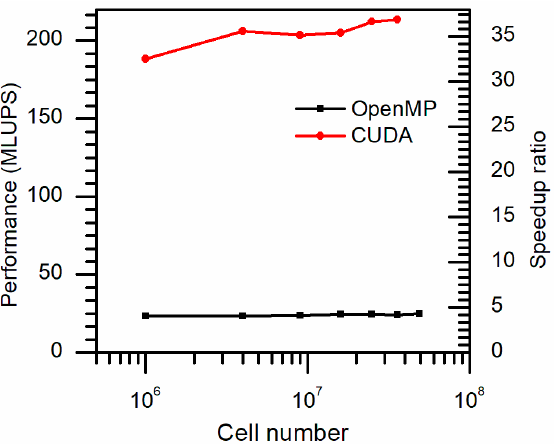
Figure 13. Performance and speedup ratio of the CPU-based and GPU-based parallel simulation compared with the use of a single CPU core.